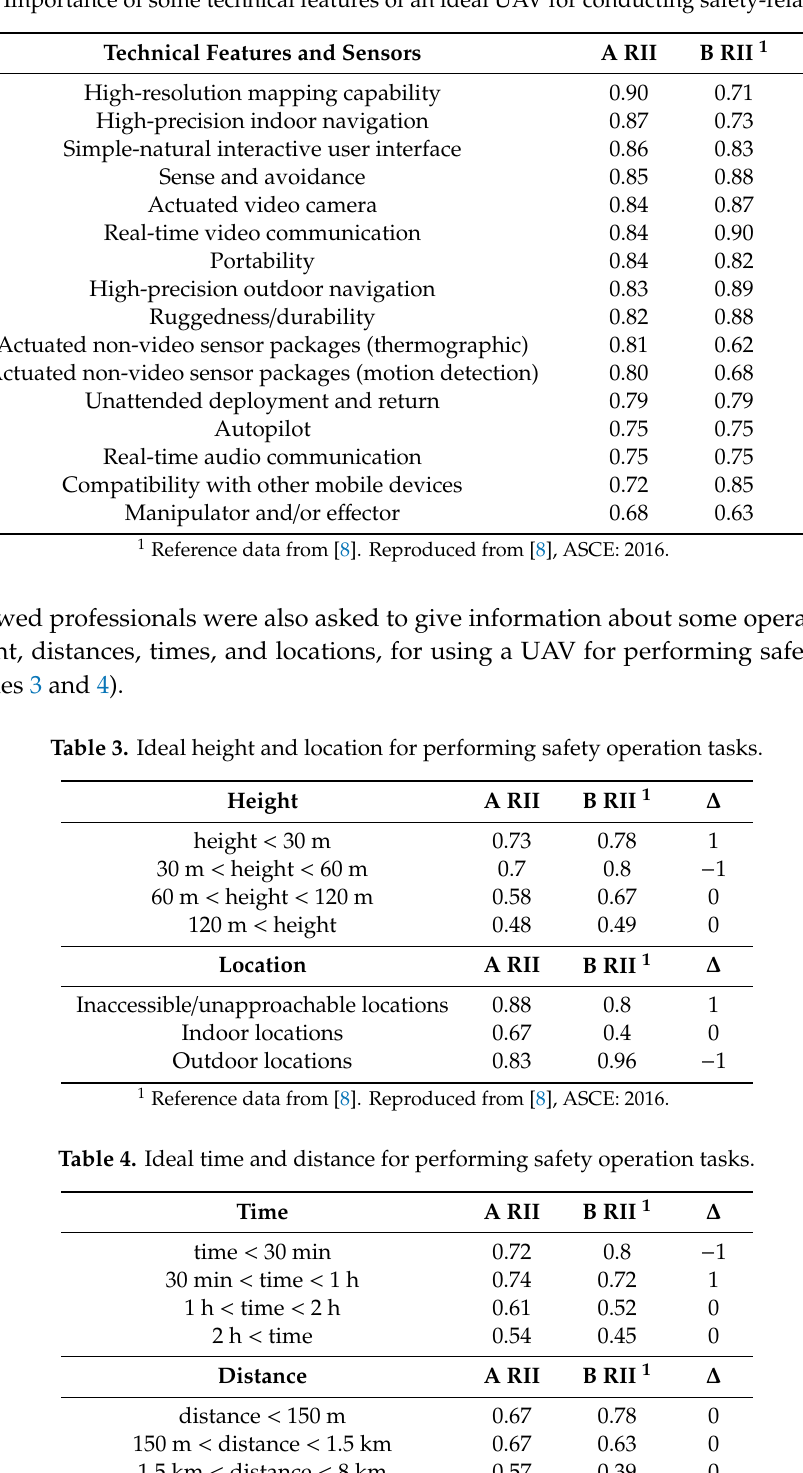
Table 2. Importance of some technical features of an ideal UAV for conducting safety-related tasks.